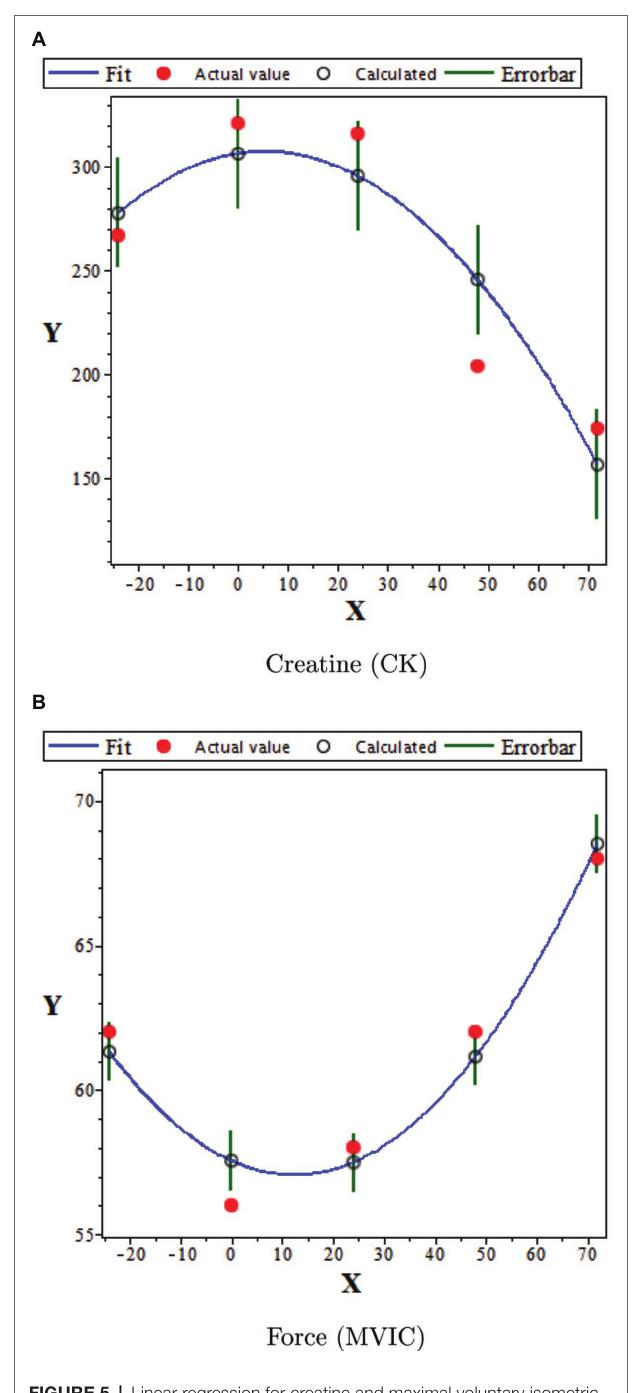
FIGURE 5 | Linear regression for creatine and maximal voluntary isometric contractions. Typical polynomial fit for the time evolution of measurements for creatine (A) and maximal voluntary isometric contractions (B) . This graph employs the data available in Table 4 for parathlete II. The model for the linear regression is Y = a 1 + a 2 X + a 3 X 2 . Here, the dependent observable Y is the measure of CK or MVIC and the dependent variable X is the time in hours. The error bars correspond to the standard deviation of the residuals (RMSE). The graphical representations for the other parathletes are equivalent to these.